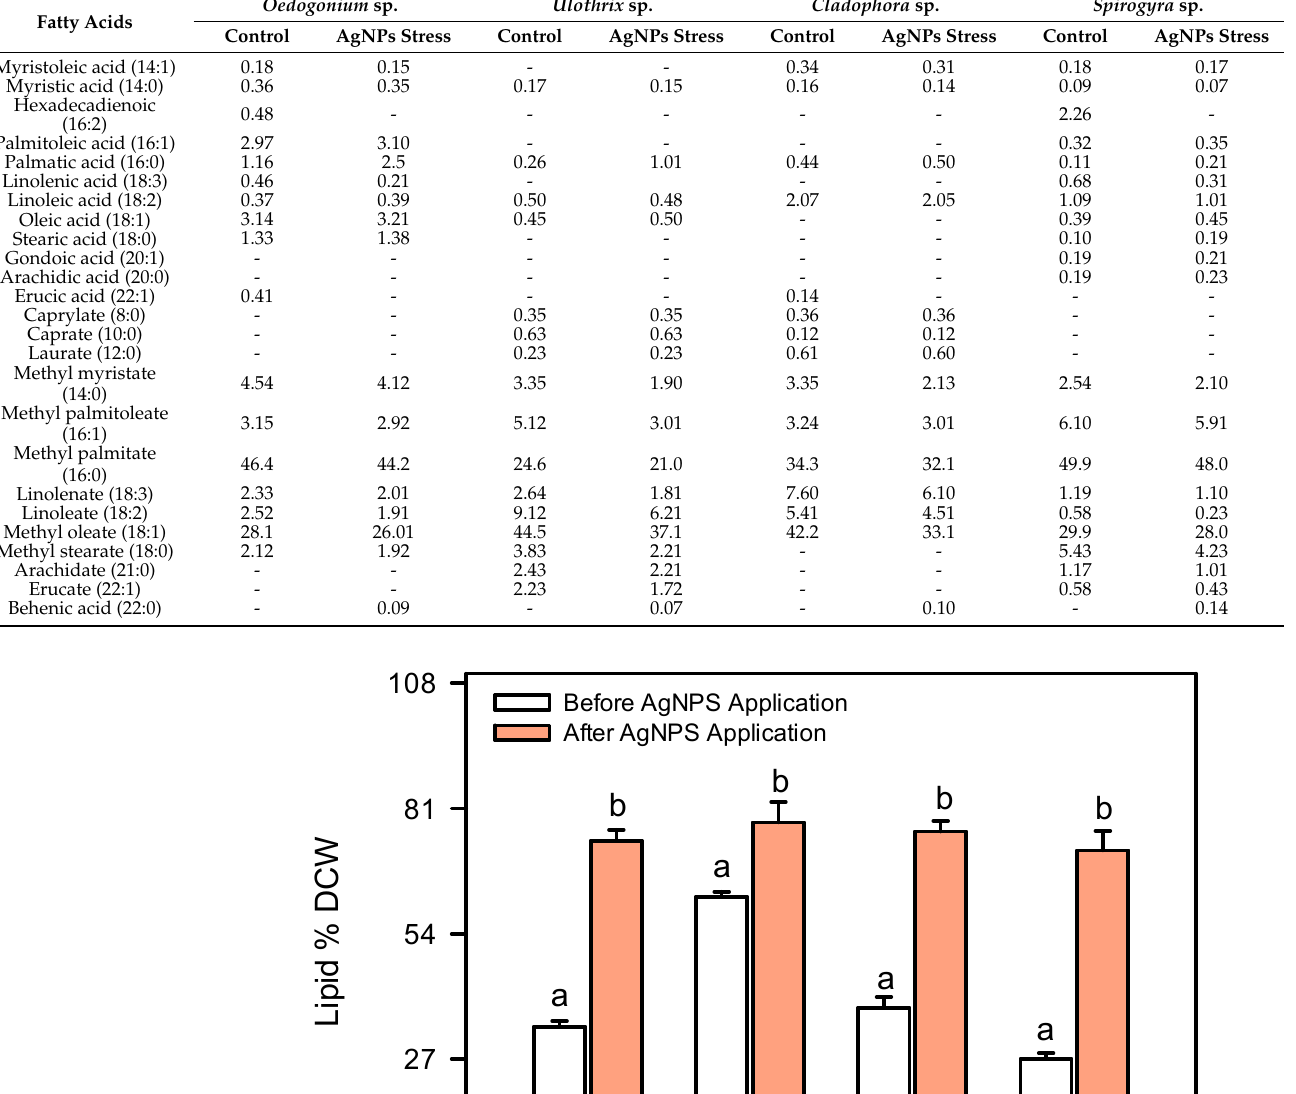
Table 4. GC-MS fatty acid profile (% DW) of algal strains before and after AgNP stress. Oedogonium sp. Ulothrix sp. Cladophora sp. Fatty Acids